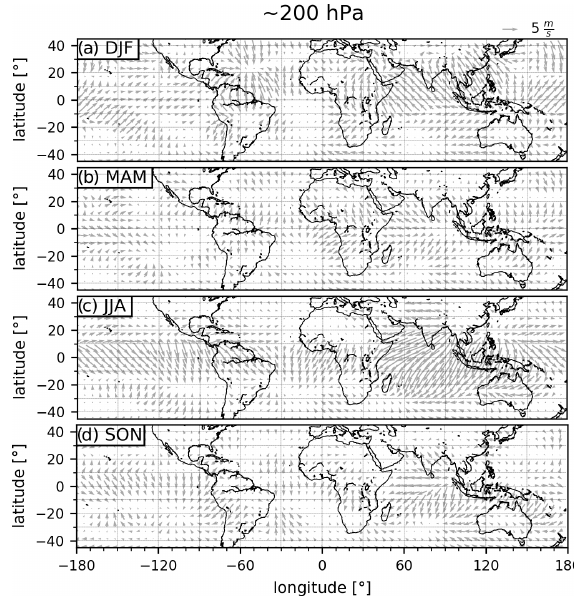
Figure A3. The 2018 mean horizontal winds for an unbalanced circulation component in ERA5 reanalysis, in different seasons, on the 200hPa pressure level. Wind intensity is shown by the length of the wind vectors.